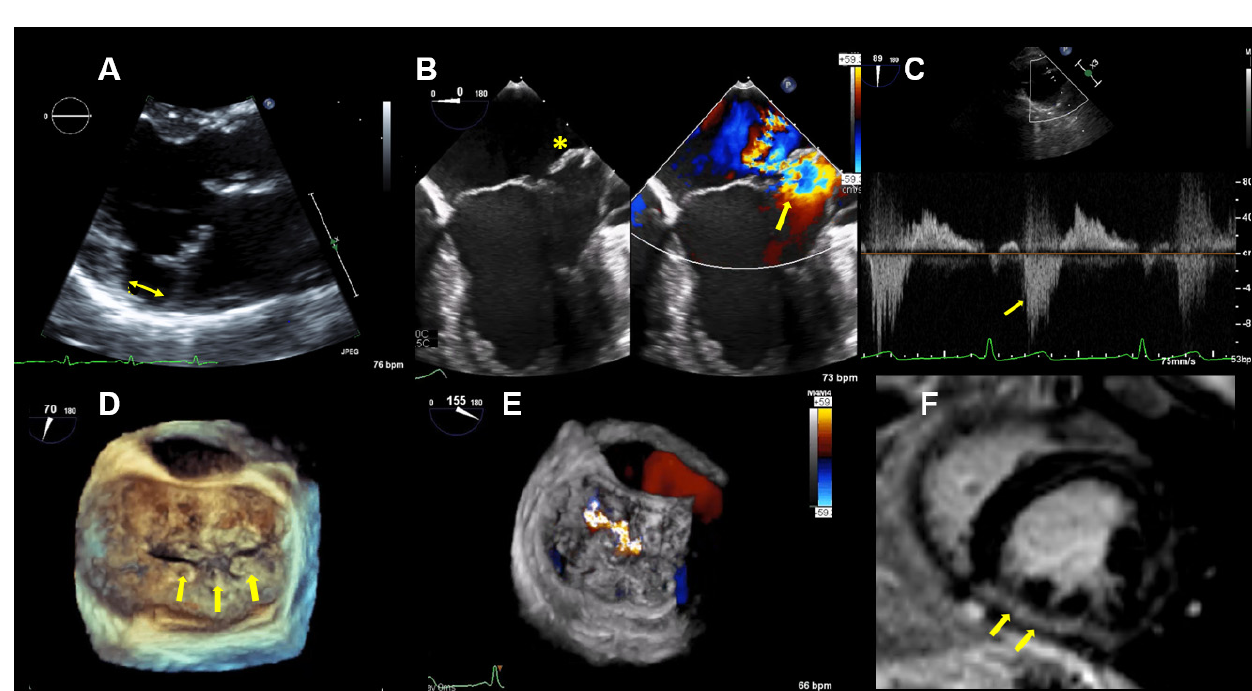
Figure 3. Case 2: Summary of the key findings from multimodality imaging. ( A ) The mitral annular disjunction (yellow double arrow) is visualized in a 3D transthoracic echocardiography view. ( B ) A 4-chamber transesophageal echocardio- graphic (TEE) view shows the bi-leaflet prolapse, which is more pronounced in the posterior leaflet (yellow asterisk), thus resulting in an eccentric mitral regurgitation (MR) jet, as seen in color Doppler (right; yellow arrow). ( C ) The pulsed-wave Doppler profile derived in the left superior pulmonary vein shows a reverse systolic flow (yellow arrow) as a sign of severe MR. ( D ) Larger prolapse segments are marked with a yellow arrow in a 3D TEE view. ( E ) The MR is seen in a 3D TEE enface view with color Doppler. ( F ) Cardiac magnetic resonance imaging reveals focal mid-wall and subendocardial fibrosis in the mid-inferior wall (yellow arrows).